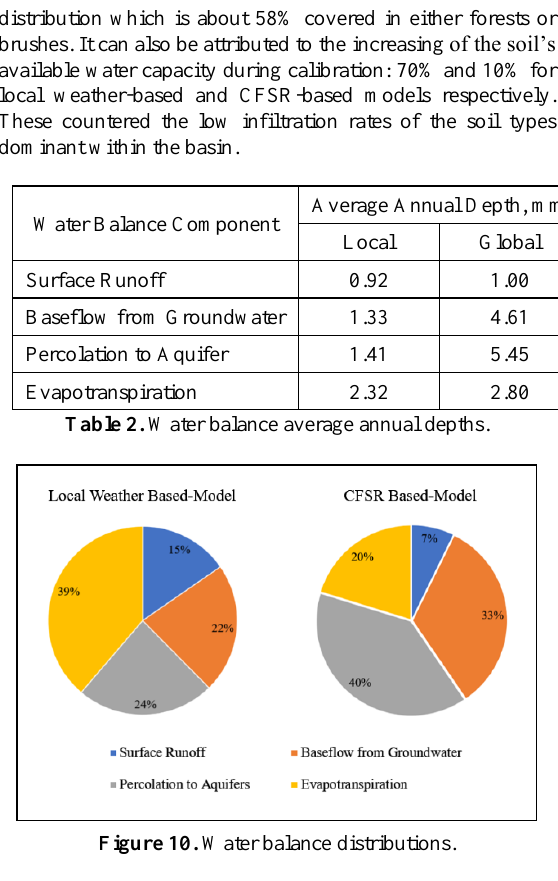
Figure 10. Water balance